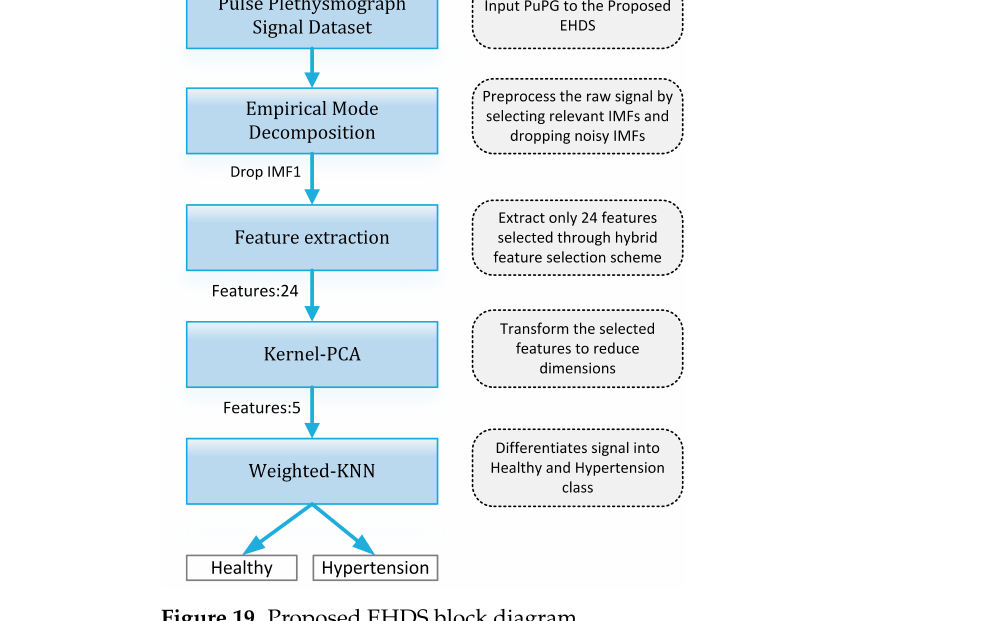
Figure 19. Proposed EHDS block diagram.